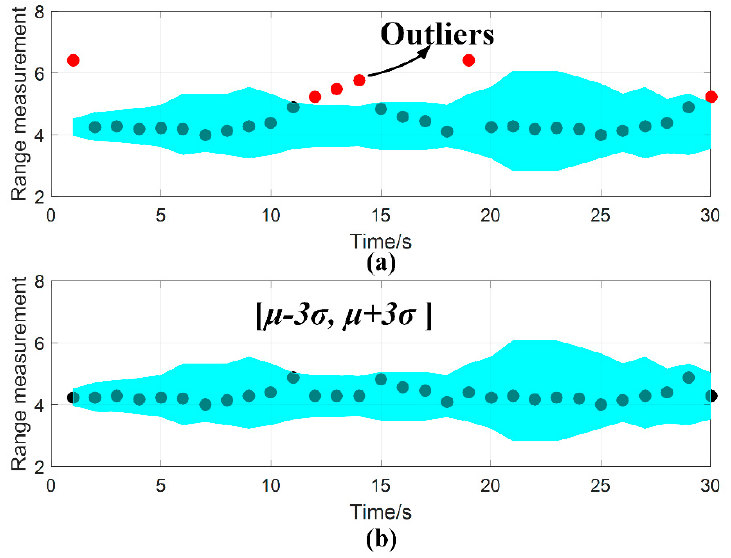
Figure 7. The presentation of the range measurements without and with the Hample filtering method: ( a ) shows the range measurements without Hample filtering being used, ( b ) presents the range measurements processed by Hample filtering.